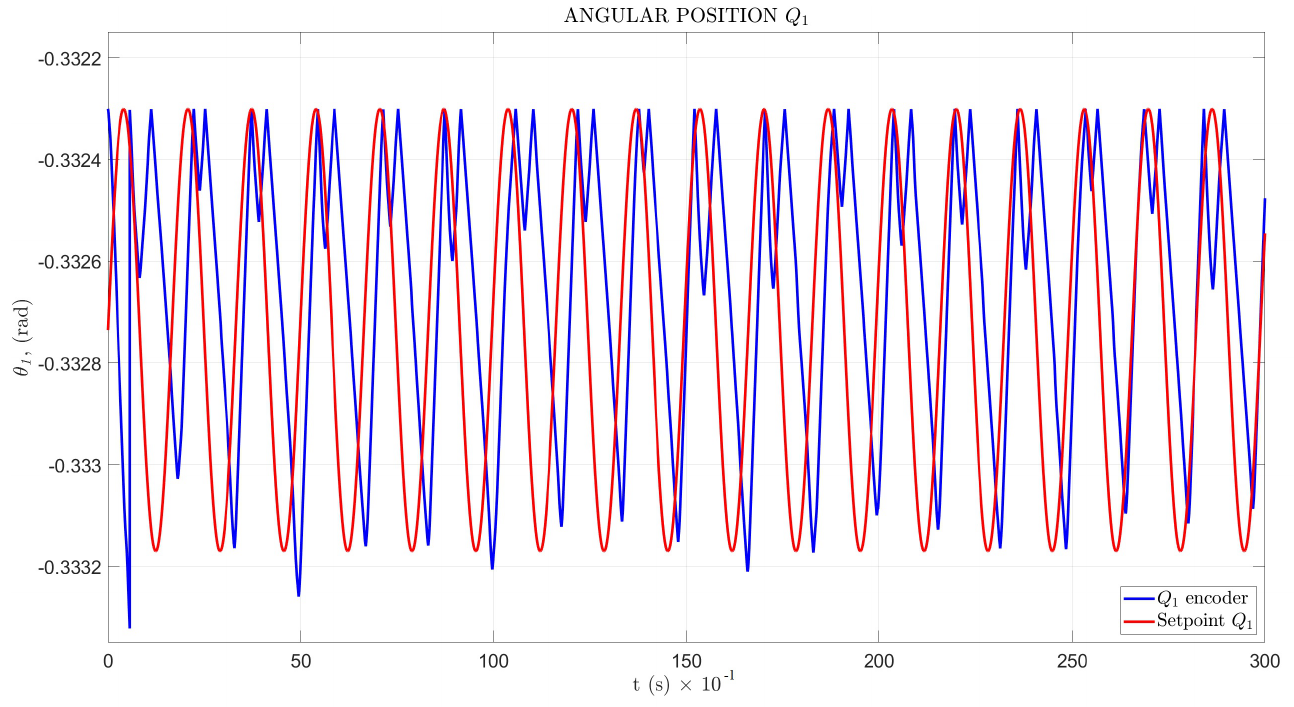
Figure 17. Angular position for Q 1 .